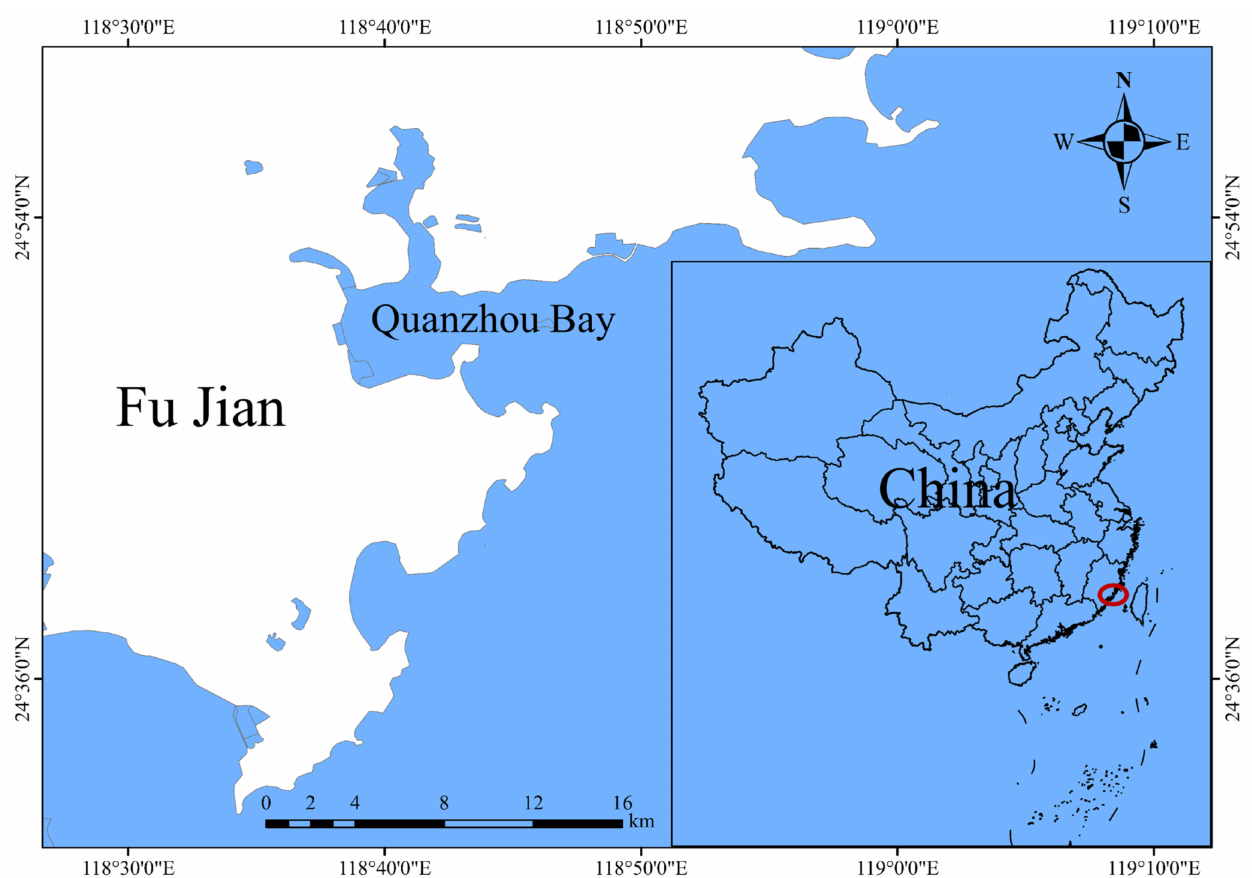
Figure 1. Map of sampling locations in the Quanzhou Bay of Quanzhou (Fujian Province,